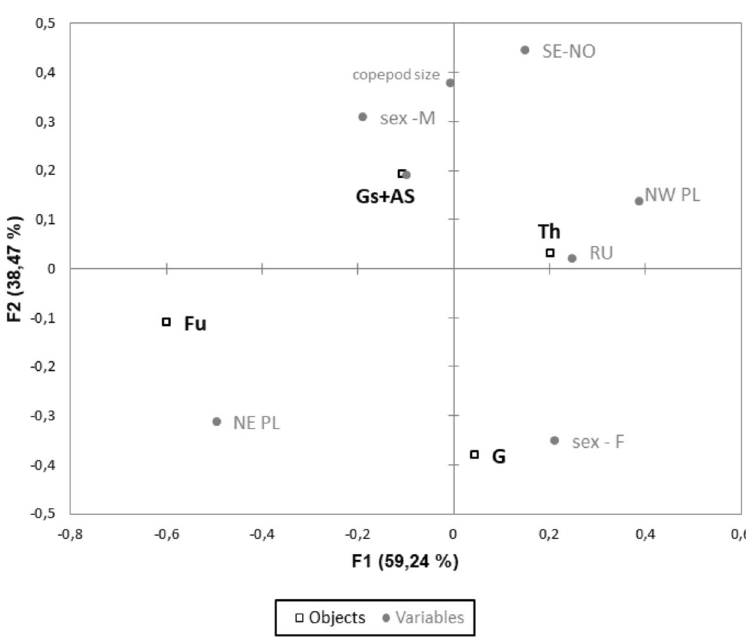
Figure 6. Canonical correspondence analysis ordination diagram showing the infection intensity of certain body parts of Eurytemora (G—cephalosome, Th—pedigerous somite, Gs + As—genital somite and anal somite, Fu—caudal ramus), with respect to sex (M—male, F—female), region (NE PL—northeastern Poland, NW PL— northwestern Poland, SE-NO—Sweden and Norway, RU—Russia), and body size of